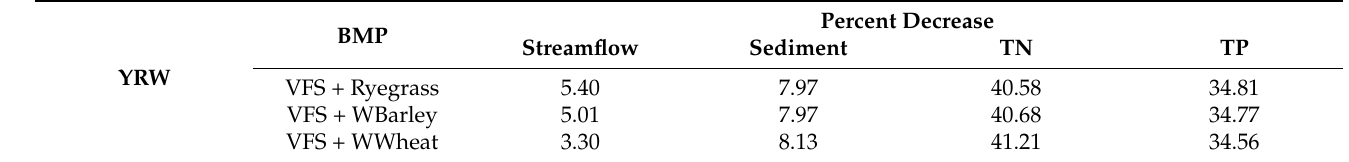
Table 3. Percentage reductions when different BMPs were implemented in YRW.